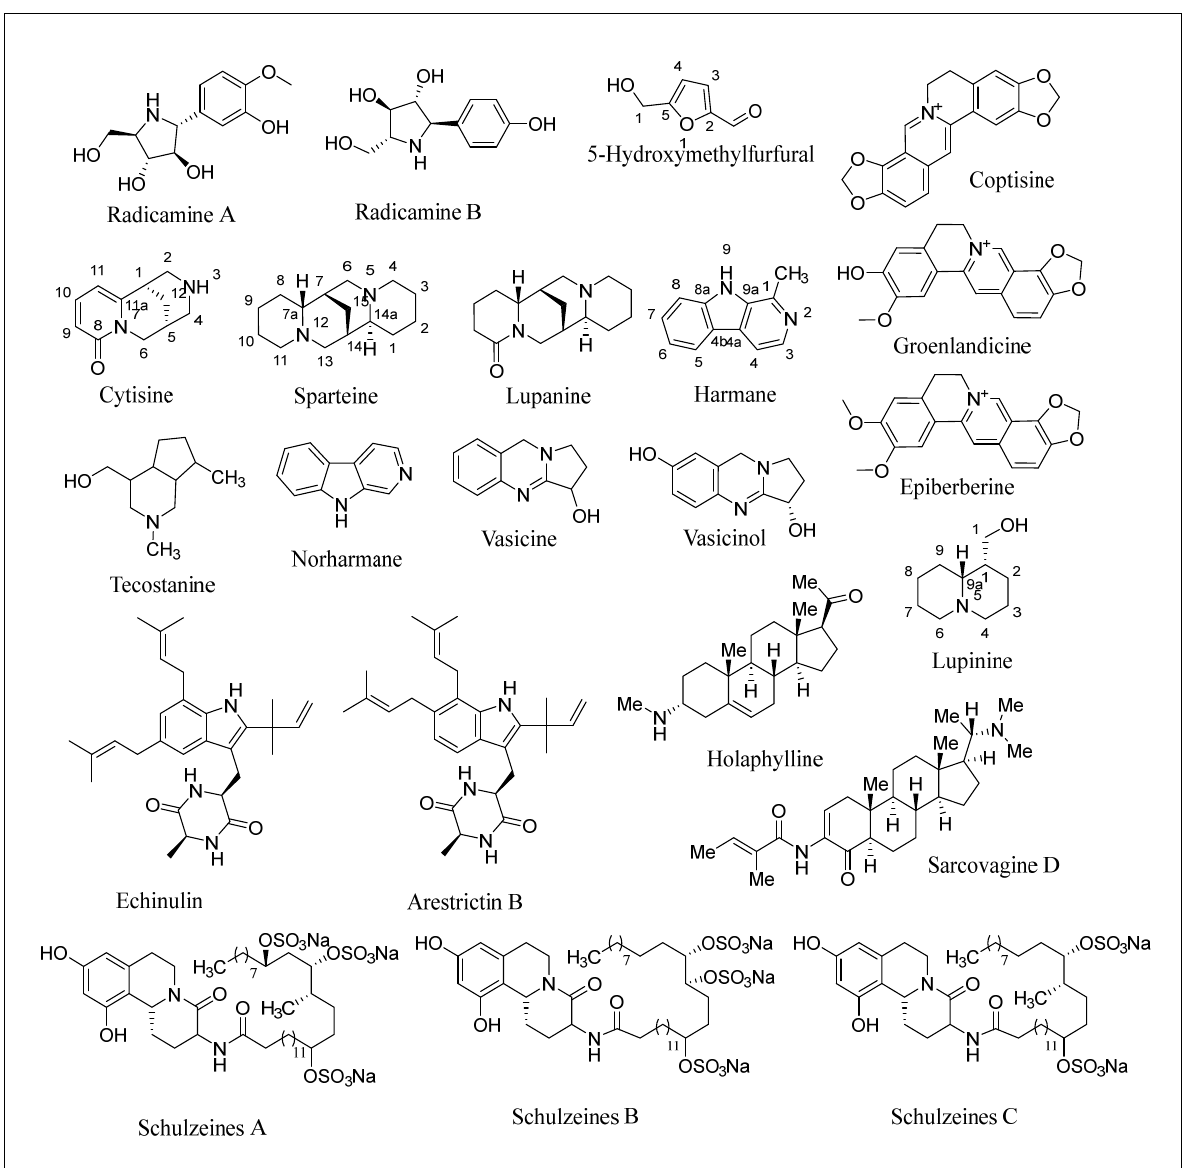
Figure 3. Regulation and management of diabetes mellitus through cellular signaling mediated by alkaloidal phytoconstituents.